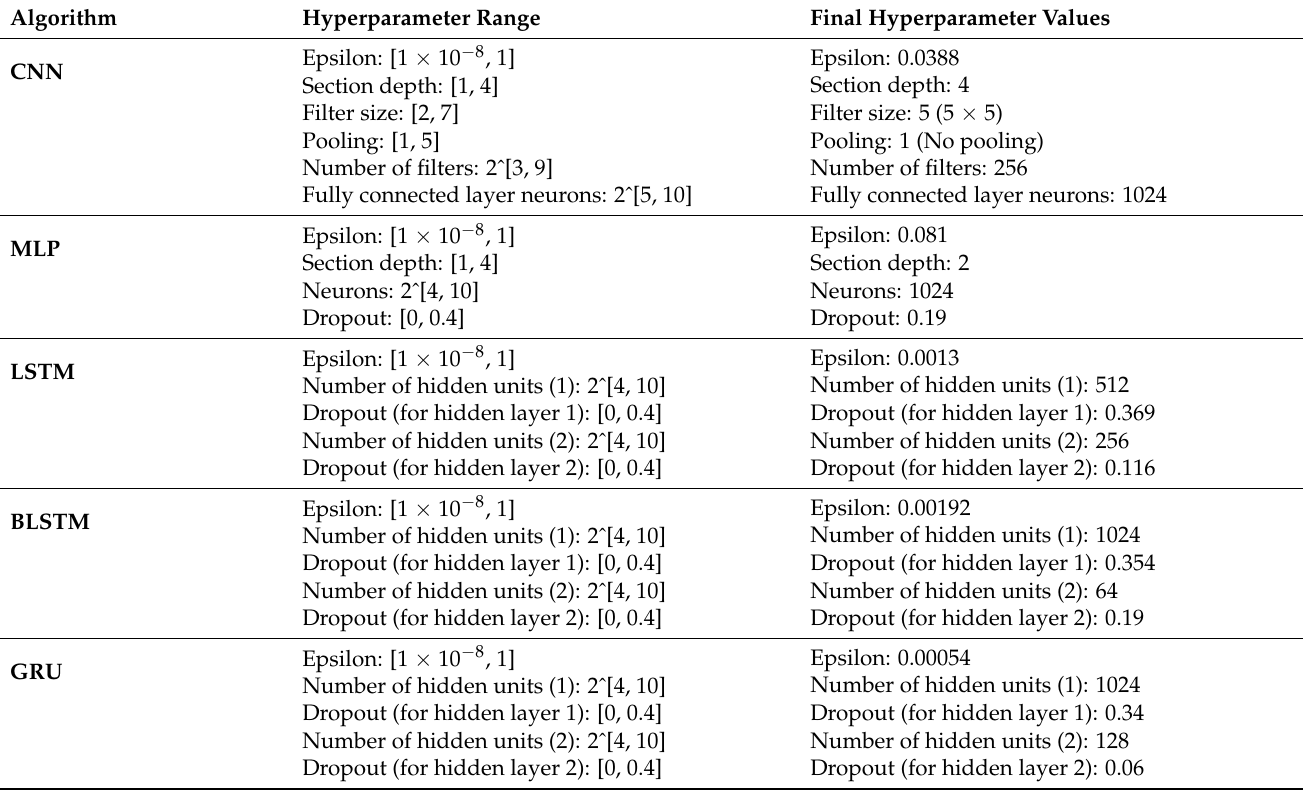
Table 2. Neural Network Hyperparameter Values Used in the Final Tuned Identity Models.